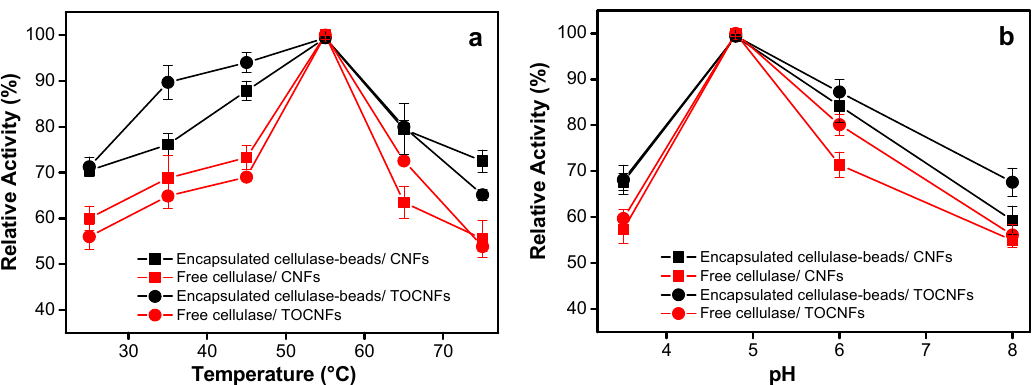
Figure 4. Relative activity of entrapped cellulase in alginate beads of optimized formulation F1, Table 1 (2% (w/v) alginate, 0.2 M CaCl 2 , 1 h hardening time) containing 0.2 M of NaCl, in comparison to free enzyme; showing the degradation of two different cellulose nanofiber samples (CNFs and TOCNFs) after 1 h: ( a ) at different temperatures at pH 4.8; ( b ) at different pHs at 55 °C.